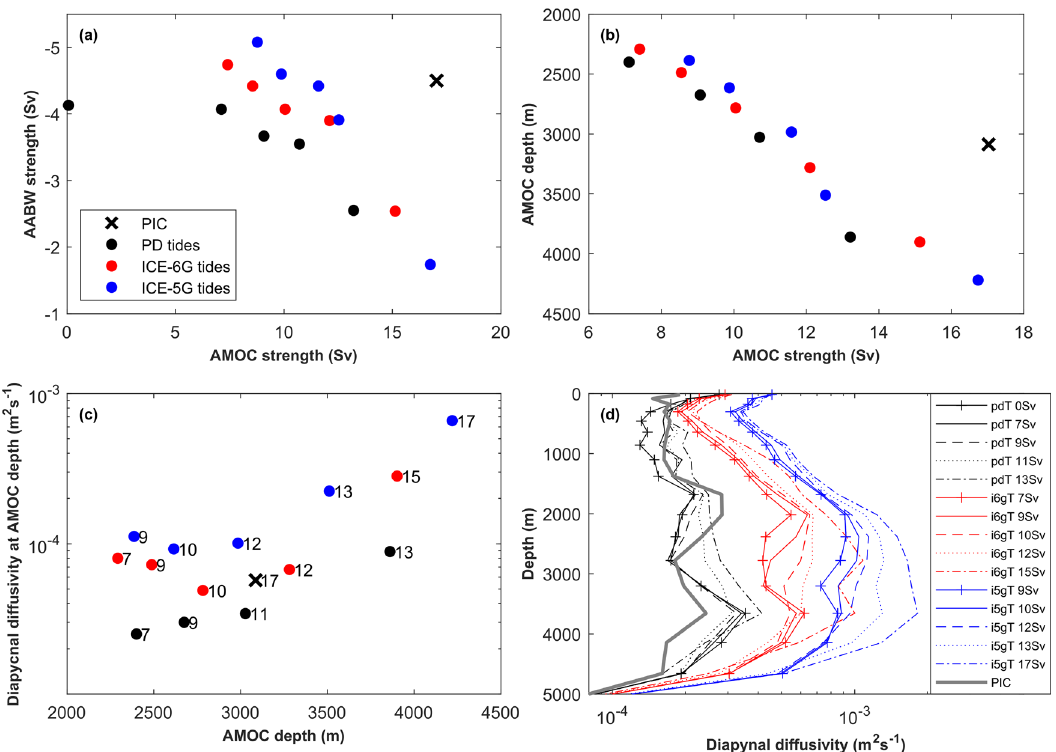
Fig. 2 Relationship between Atlantic circulation structure and diapycnal diffusivities. ( a ) Atlantic meridional overturning streamfunction (AMOC) strength at 25°N versus Antarctic Bottom Water (AABW) strength in the Atlantic at 35°S for the simulation ensemble with markers colored by the tidal forcing. ( b ) AMOC strength versus AMOC depth (AMOC depth was determined as the depth of the zero streamfunction isoline between 30°N and 30°S, which also represents the interface between AABW and North Atlantic Deep Water) with markers colored by tidal forcing. ( c ) Horizontally averaged Atlantic diapycnal diffusivities between 30°S and 30°N at the base of the AMOC cell as determined by the depth of the zero-streamfunction isoline. AMOC strength for each simulation is listed next to the markers. ( d ) Vertical pro fi les of horizontally averaged Atlantic diapycnal diffusivities ( k v